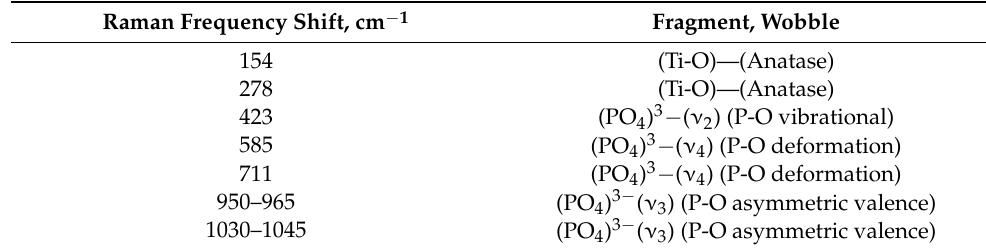
Figure 9. Raman spectrum of the hydroxyapatite coating obtained by the PEO/GDS method. Table 5. Results of the hydroxyapatite coating with different frequencies of corresponding lines.